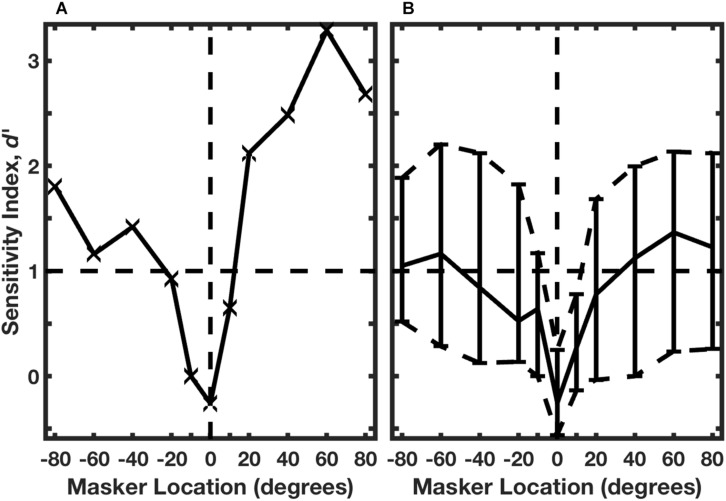
Neural classification of rhythms. (A) An isolated single neuron. The target was fixed at 0°, and the masker source was varied parametrically. A regression procedure was used to identify Rhythm 1 or 2 based on the temporal patterns of neural spike counts. Performance is given by d’, based on trial-by-trial distributions of spike patterns across 10 trials. The horizontal dashed line indicates the RMR threshold criterion of d’ = 1. Data are from the same unit represented in Figure 7. (B) Distribution of performance across 57 isolated single neurons. The solid curve shows the median, and dashed curves show the 25th and 75th percentiles. (From Middlebrooks and Bremen, 2013).